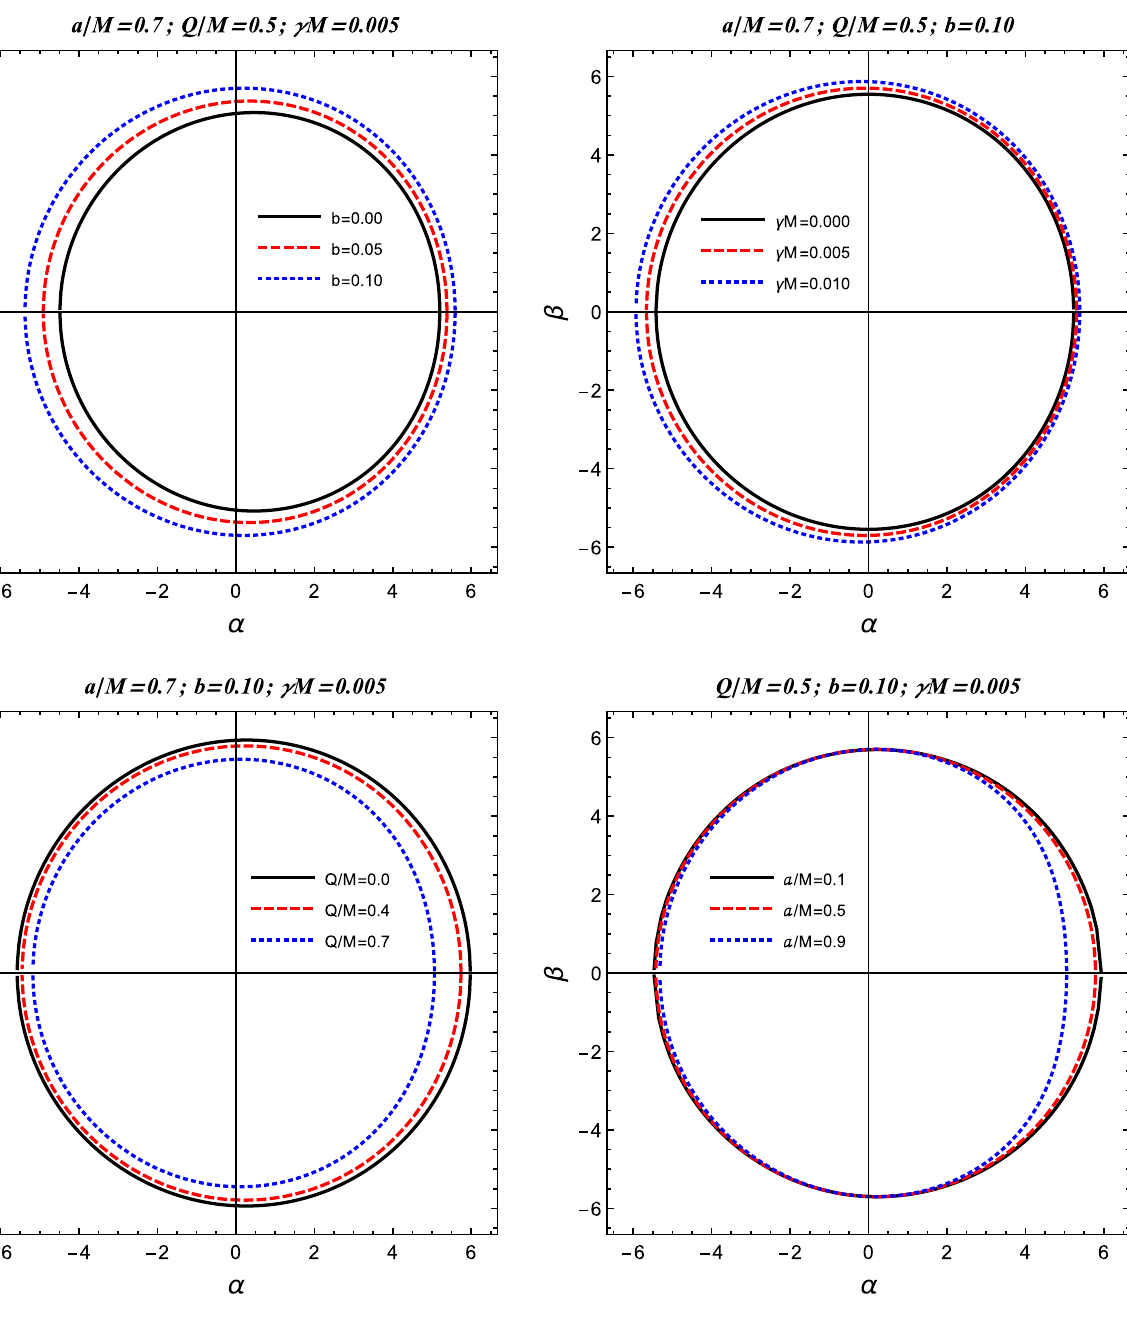
the KNKL black hole. Further, form the Fig. 3 we observe that the increasing values of the spin parameter a enhances thedistortionoftheshadowoftheKNKLblackhole,forfixed values of the other spacetime parameters. Thus the shadow cast by a fast rotating black hole would be more distorted as compared to the one cast by a slowly rotating black hole. This observation may be helpful in constraining the spin of a rotating black hole. Here we see that all the spacetime